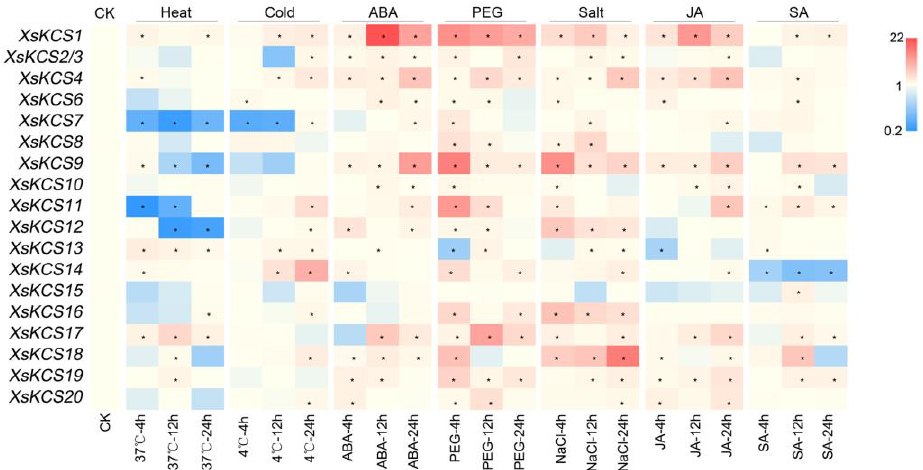
Figure 6. The expression profiles of XsKCS genes in different tissue. Error bars indicate SD.